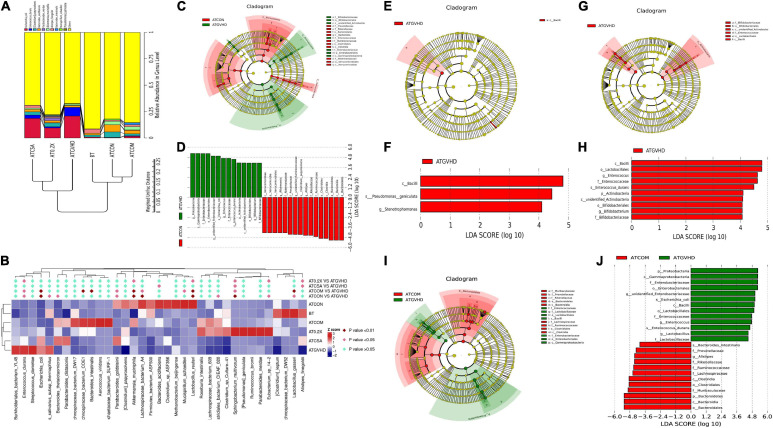
Combination treatment reversed the dysbiosis in GVHD mice on the species level. (A) The UPGMA tree of the top 10 species in abundance based on weighted UniFrac distances in the species level. The relative abundances of enteric bacteria at the species level in different groups of mice were assessed using 16S high-throughput sequencing after BMT on day 7. n = 4–6/group. (B) The statistical analysis of the abundance of top 35 species in gut microbiota between different groups of mice. n = 4–6/group. The heat map is color-based on row Z scores. The groups with the highest and lowest bacterial level are marked in red and blue, respectively. The combination treatment significantly down-regulated the relative abundance of E. coli and Enterococcus durans. (C–J) Cladograms (C,E,G,I) and LDA (linear discriminant analysis) score (D,F,H,J) generated by LEfSe (linear discriminant analysis effect size) indicating differences in bacterial taxa in different groups of mice 7 days after the BMT. n = 4–6/group. The central point represents the root of the tree (bacteria), and each ring represents the next lower taxonomic level (from phylum to genus). The diameter of each circle represents the relative abundance of the taxon. Only the taxa meeting a significant LDA threshold value of >2 are shown. The species in the non-transplant group (ATCON) and the combo treatment group (ATCOM) were indicated with a negative LDA score (D,J). (C,D) LEfSe analysis of the ATCON vs. the GVHD group. The potential biomarkers of the GVHD group: (1). Proteobacteria, Gammaproteobacteria, Enterobacteriales, Enterobacteriaceae, unidentified Enterobacteriaceae, E. coli; (2). Firmicutes, Bacilli, Lactobacillales, Enterococcaceae, Enterococcus, E. durans. The potential biomarkers of the ATCON group: (1). Bacteroidetes, Bacteroidia, Bacteroidales, Rikenellaceae, Alistipes; (2). Firmicutes, Clostridia, Clostridiales, Ruminococcaceae, unidentified Ruminococcaceae, Clostridium papyrosolvens; (3). Verrucomicrobia, Verrucomicrobiae, Verrucomicrobiales, Akkermansiaceae, Akkermansia. (E,F) The LEfSe analysis of the GVHD vs. the CSA group. (G,H) The LEfSe analysis of the GVHD vs. the 0.2 mL/kg XBJ-treated group. (I,J) The LEfSe analysis of the GVHD vs. COM group.